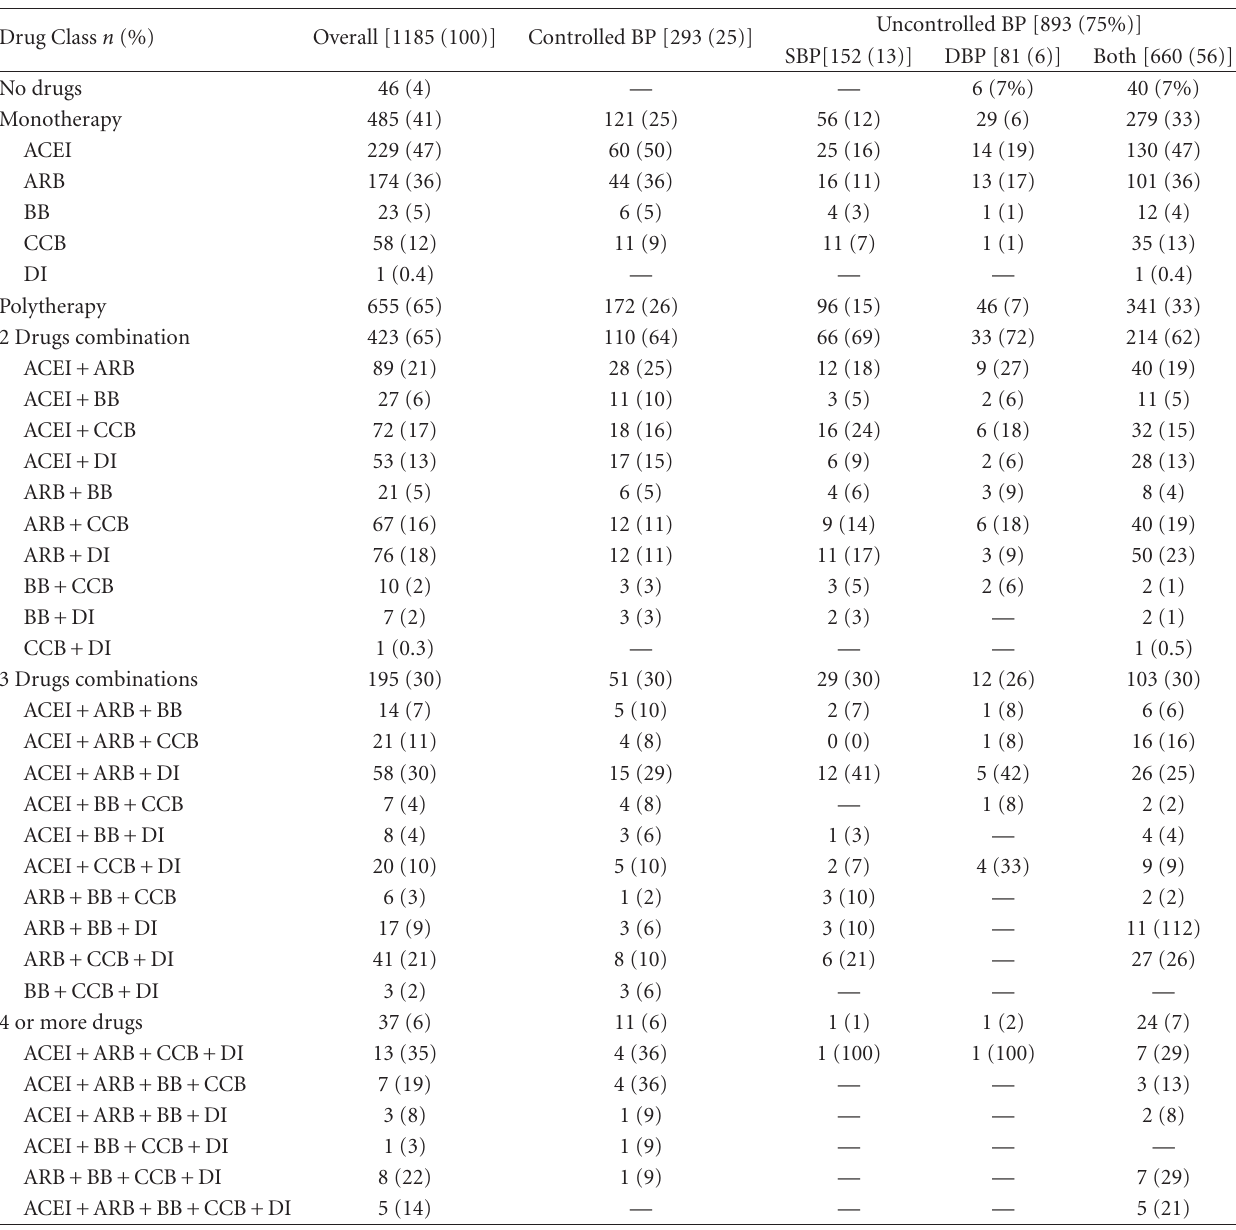
Table 3: Prescribing pattern in patients with controlled versus uncontrolled